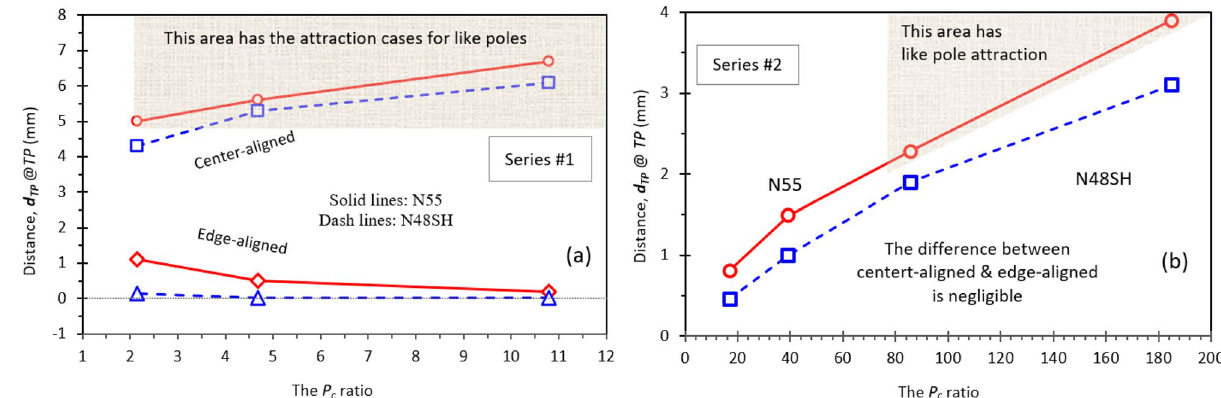
Figure 2. The relationship of the distance d TP at TP and the P c ratio. ( a ) Series #1 (thin magnet pairs) and ( b ) Series #2 (thick magnet pairs). A larger d TP indicates a stronger LD effect and a greater possibility of attraction between the like poles. In Series #1(thin magnet pairs) both N55 and N48SH show a large difference in d TP between the center- and edge-aligned. In Series #2 (thick pairs) have negligible differences between the two